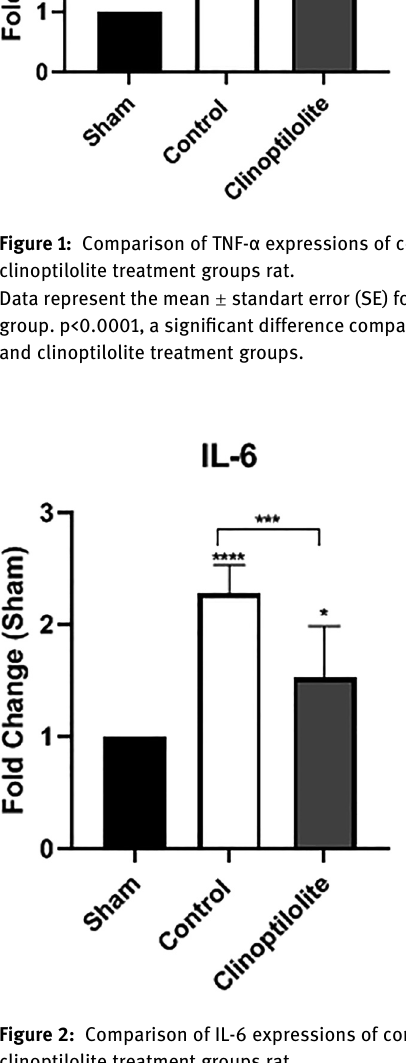
Figure 2: Comparison of IL-6 expressions of control, sham, and clinoptilolite treatment groups